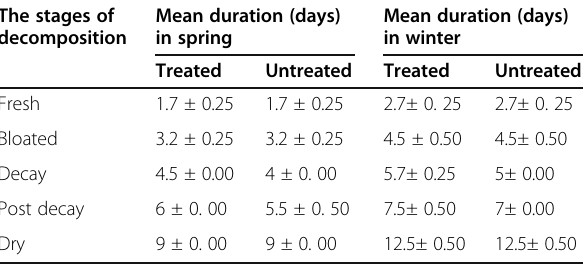
Table 3 Mean duration (days) of the different decomposition stages in days for methadone-treated and untreated carcasses The stages of Mean duration (days) decomposition in